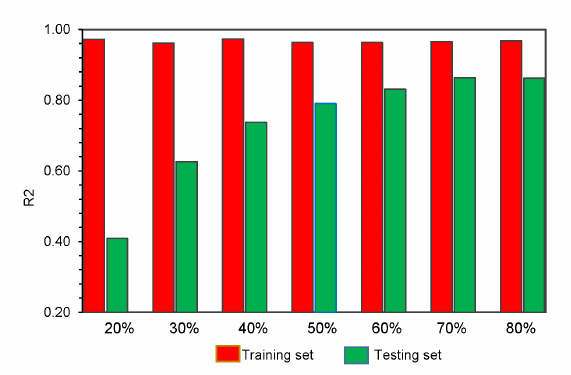
Fig. 5. Performance of the DNN model using different training set